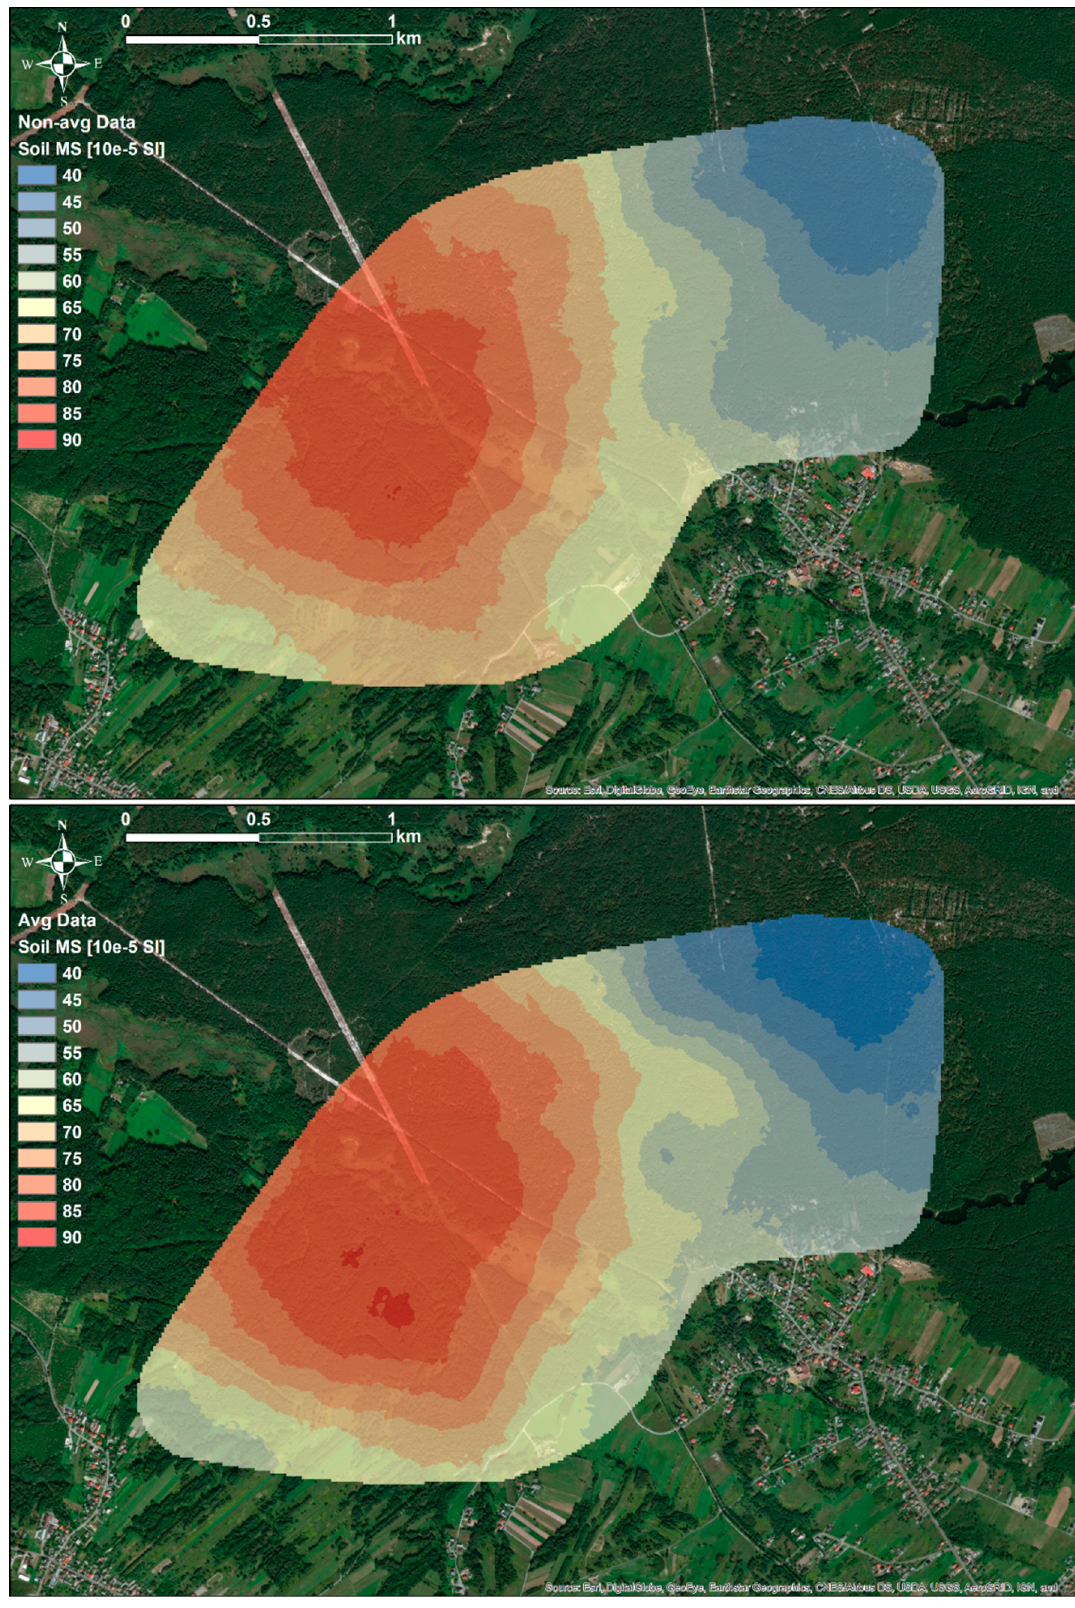
Figure 2. Spatial distributions of κ sim-avg simulated using κ non-avg (upper figure) and κ avg (bottom figure) data sets.